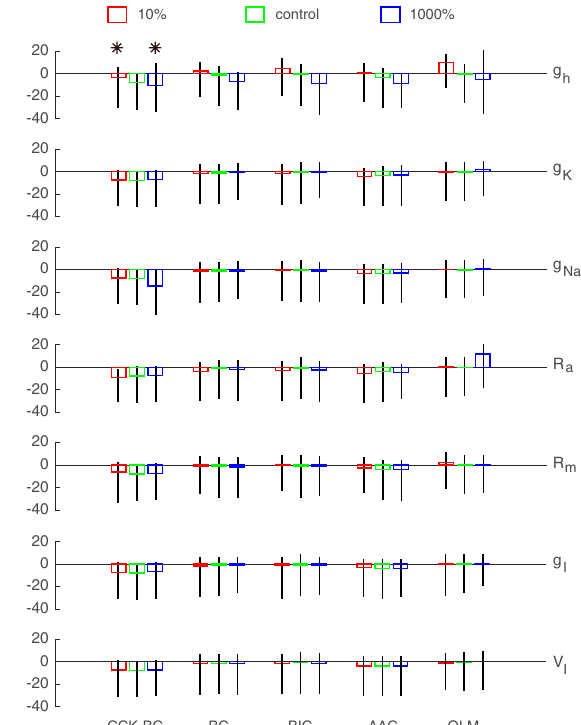
Figure 6. Sensitivity analysis of the parameters in the realistic pyramidal neuron model. Data of the five theta- driving neurons over 12 non-overlapping time segments are analyzed. Black bars indicate the range of the peak time and rectangle bars indicate the mean value of the peak time. Colors indicate the parameter range from 10% (red) to 1000% (blue) for all rows except the last one in which colors indicate the inhibitory reversal potential vary by increment of − 10 mV (red) to + 10 mV (blue) with respect to the control values (green) used in our realistic simulations. Asterisks are used to emphasize that the change of cation channel density g h will lead to a substantial change of the positive peak time for